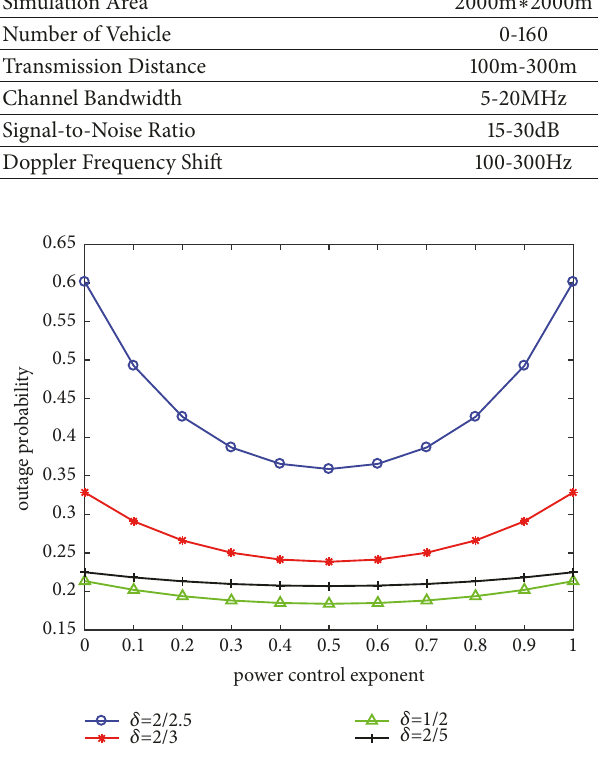
Figure 3: Power control exponents 𝑤 versus outage probability.